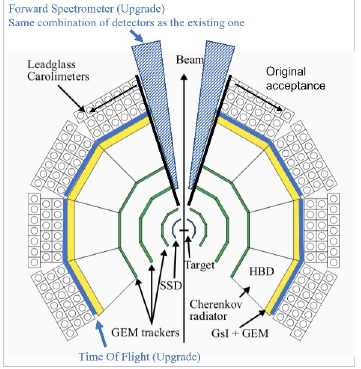
Figure 3. Schematic view of upgrades of the existing spectrometer